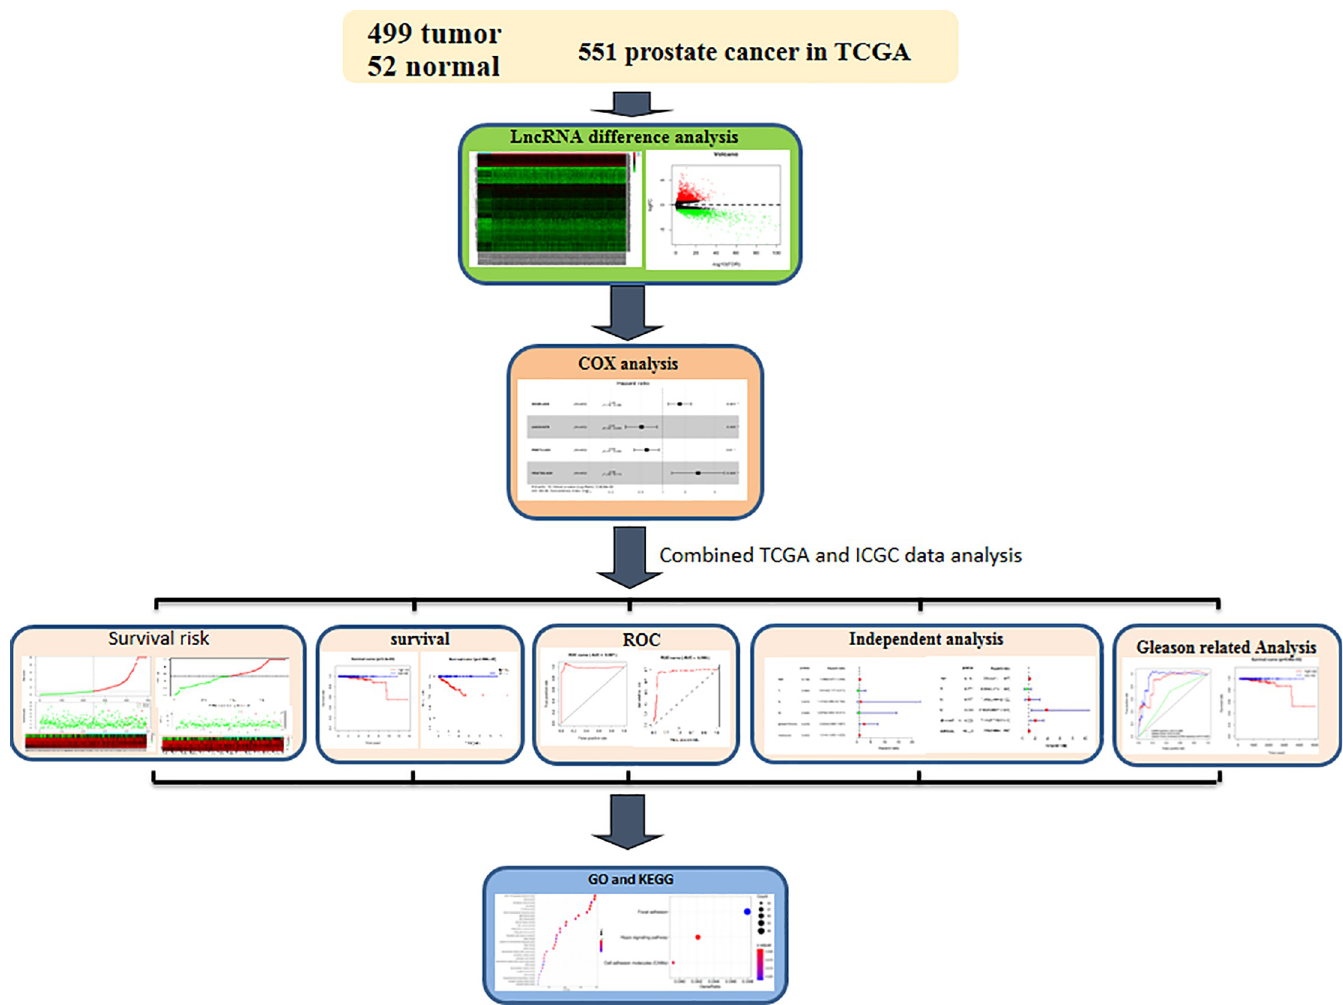
Fig 1. The overall analysis design of our